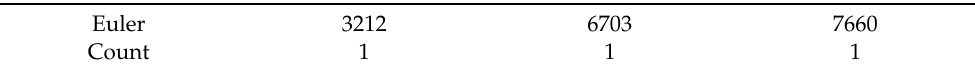
Table 2. First, second and third decomposition types (from left to right)—distributions of combinato- rial Euler characteristics of Tetrahedron3DNet objects.